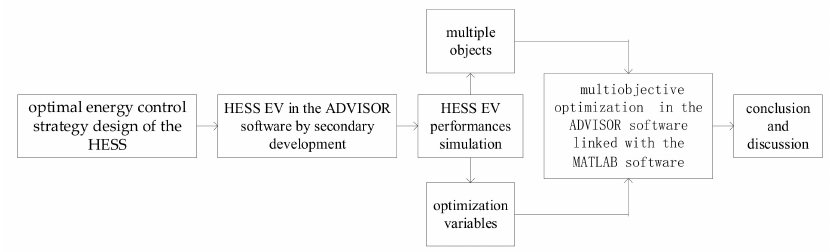
Figure 2. The scheme of the multiobjective optimization for the HESS EV.